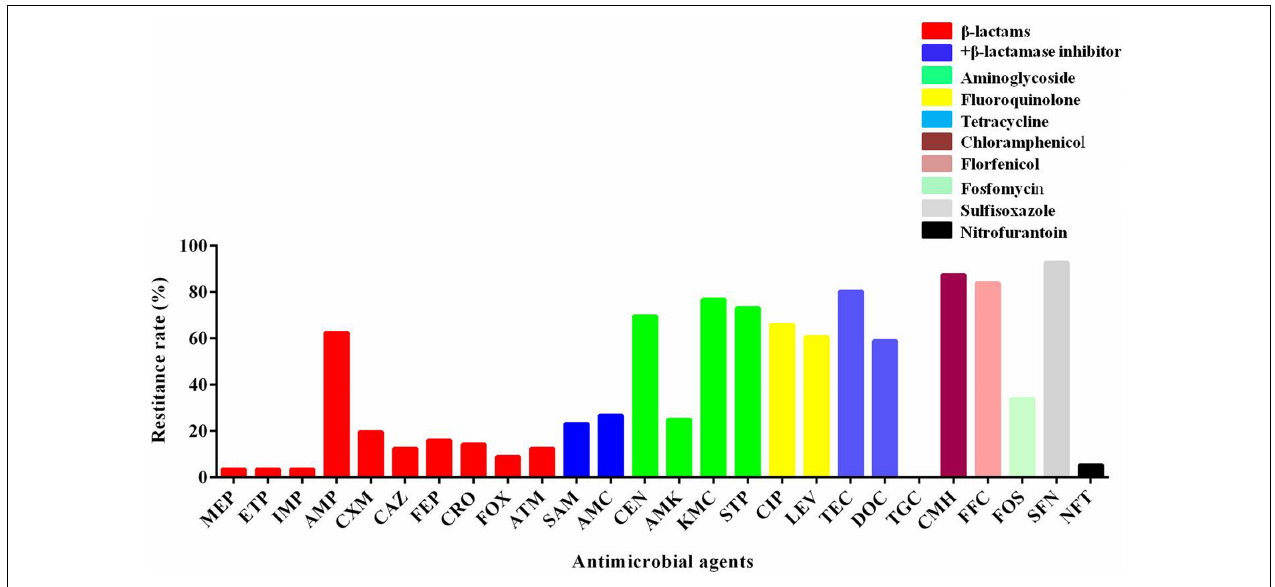
FIGURE 1 | The resistant rate of mcr-1- positive E. coli to other antibiotics. MEP, meropenem; ETP, ertapenem; IMP, imipenem; AMP, ampicillin; CXM, cefuroxime; CAZ, ceftazidime; FEP, cefepime; CRO, ceftriaxone; FOX, cefoxitin; ATM, aztreonam; SAM, ampicillin–sulbactam; AMC, amoxicillin–clavulanic acid; GEN, gentamicin; AMK, amikacin; KMC, kanamycin; STP, streptomycin; CIP, ciprofloxacin; LEV, levofloxacin; TEC, tetracycline; DOC, doxycycline; TGC, tigecycline; CMH, chloramphenicol; FFC, florfenicol; FOS, fosfomycin; SFN, sulfisoxazole; NFT,